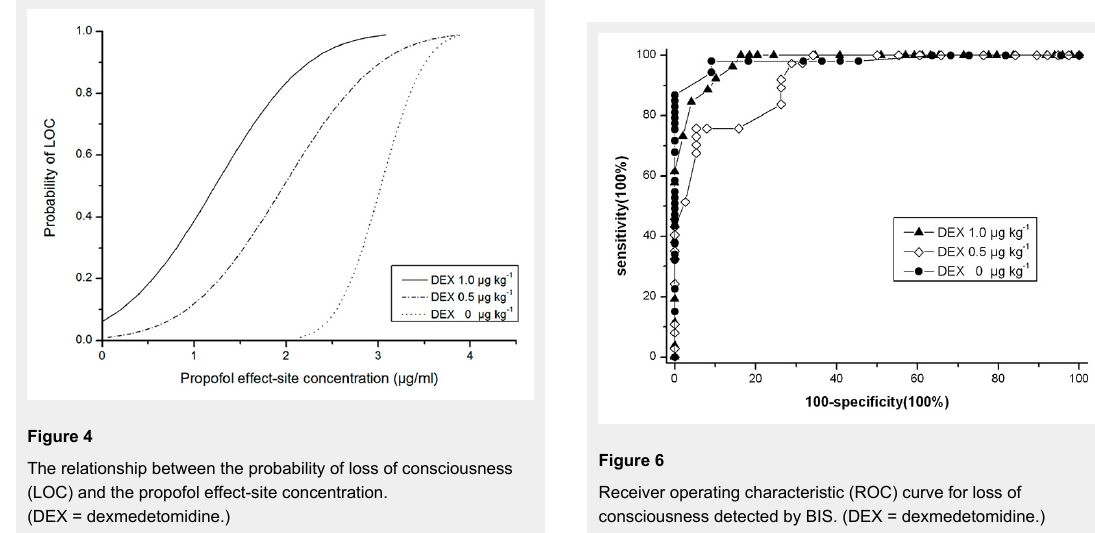
Table 3: Area under the receiver operating characteristic (ROC) curve and prediction probability (Pk) for loss of consciousness (LOC) detected by bispectral index (BIS) in the three groups. Group ROC curve area (standard error)